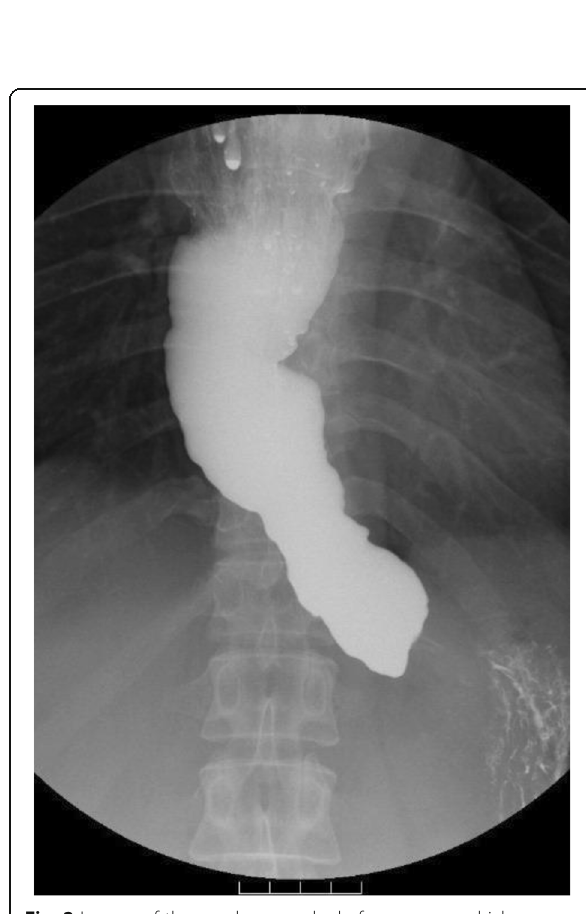
Fig. 2 Images of the esophagography before surgery, which demonstrated esophageal dilatation with a maximum transverse diameter of 55 mm, which was classified as the straight shape